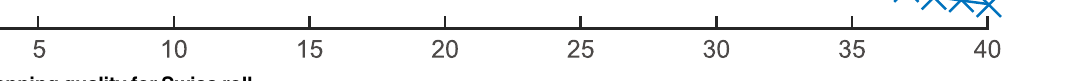
Fig 7. OVI-NG mapping quality for Swiss